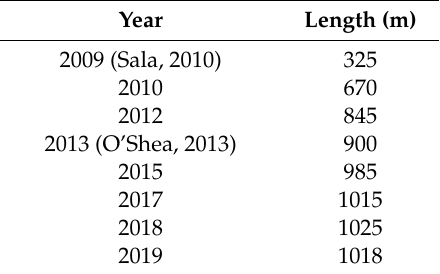
Table 3. Width breached area Rossbeigh.